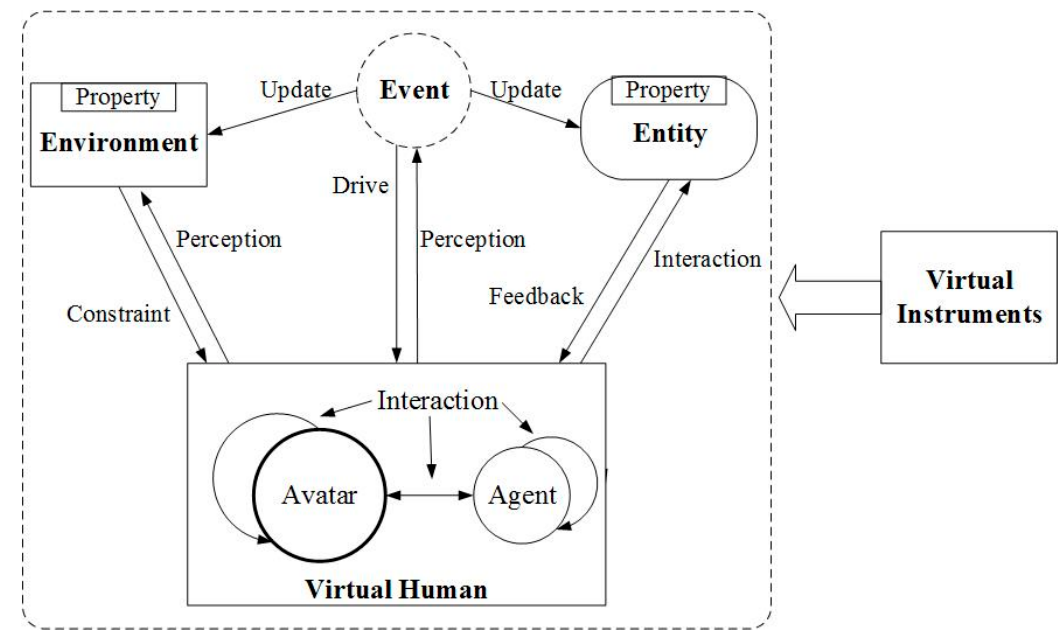
Figure 1. Heterogeneous distributed virtual geographic environment (HDVGE) conceptual framework.